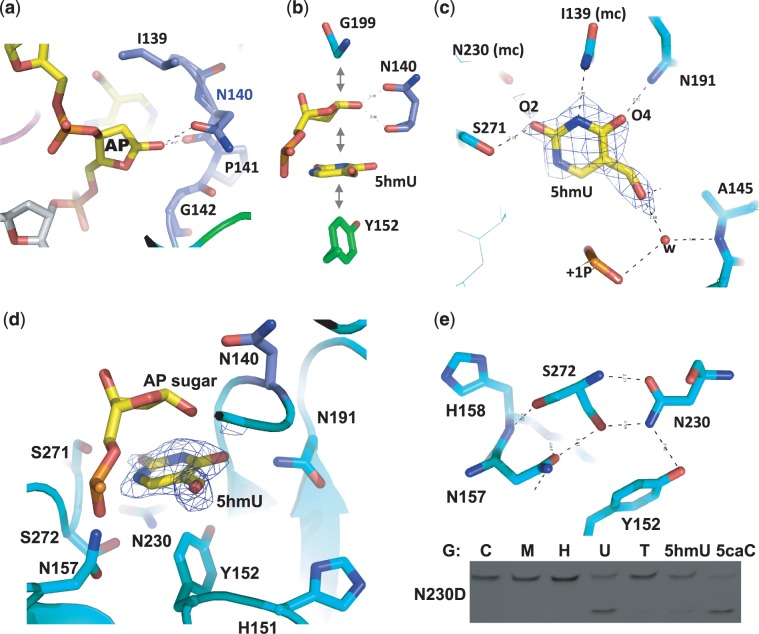
The binding of 5hmU in the active site. (a) In the WT structure, the N-glycosidic bond of the extrahelical nucleotide is cleaved, and a hydroxyl oxygen atom has been attached to the C1′ of the sugar ring (see Figure 3a inset). (b) Favorable face-to-face and edge-to-face hydrophobic interactions between the sugar, the cleaved 5hmU base and Tyr152. (c) Omit electron density, contoured at 3.5σ above the mean, is shown for omitting 5hmU. The hydrogen bond interactions (dashed lines) with the polar atoms of 5hmU are within 3.0 Å distance cutoff: mc, main-chain-atom-mediated contacts. (d) The 5hmU-binding pocket is rich in polar atoms. (e) A hydrogen-bonding network involves both side chain and main chain atoms of depicted residues. The activity of N230D is shown.